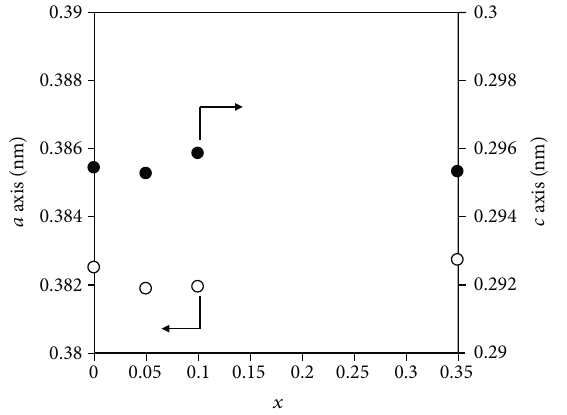
Figure 4: Lattice constant of CTNO ( x )_600.